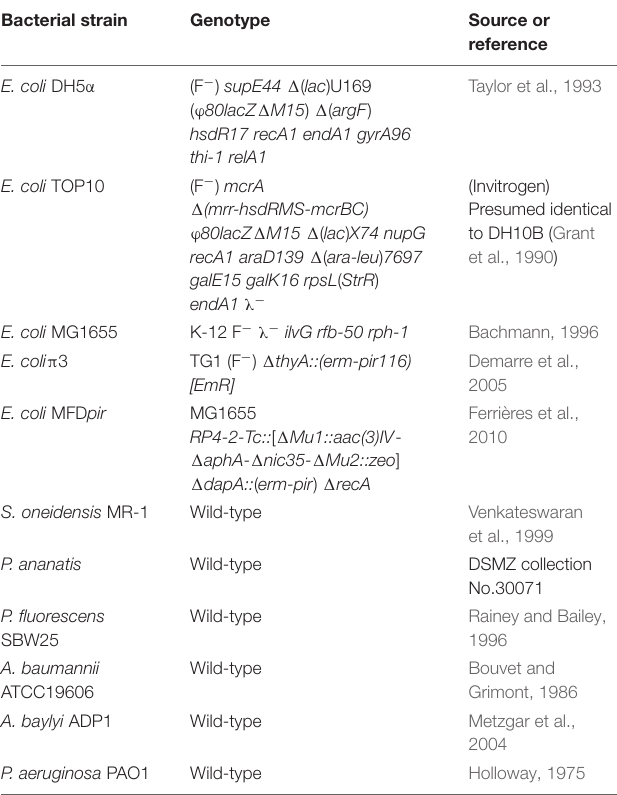
TABLE 1 | Bacterial strains used in this study. Bacterial